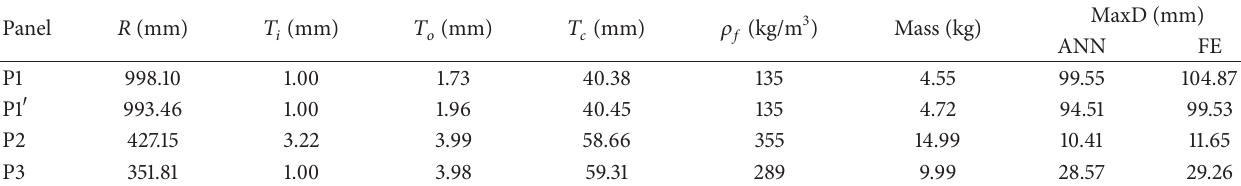
Table 5: Optimum panel designs for Case Study 1.